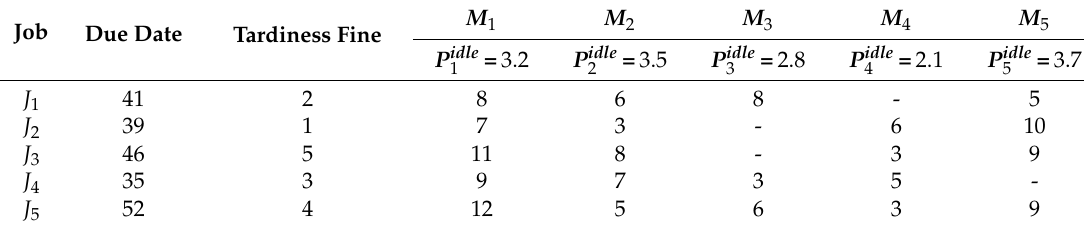
Table 2. The basic data in case 2 (5 jobs × 5 machines).